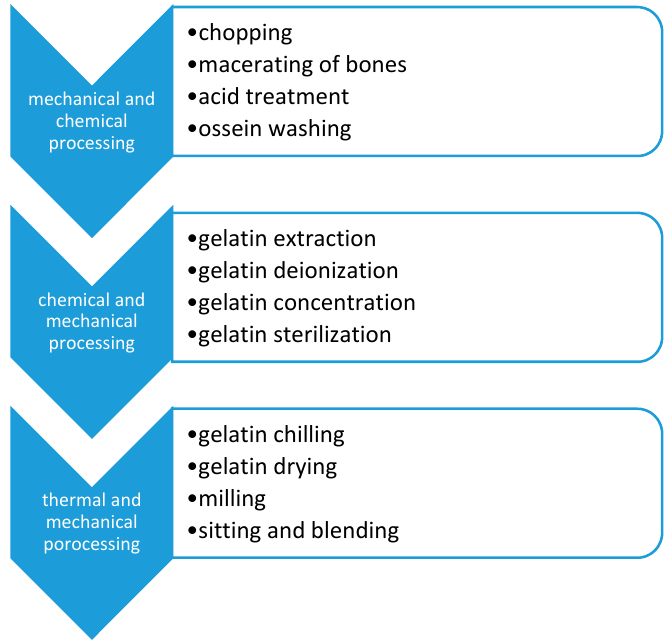
Figure 3. Process of gelatin production type A from porcine bones.